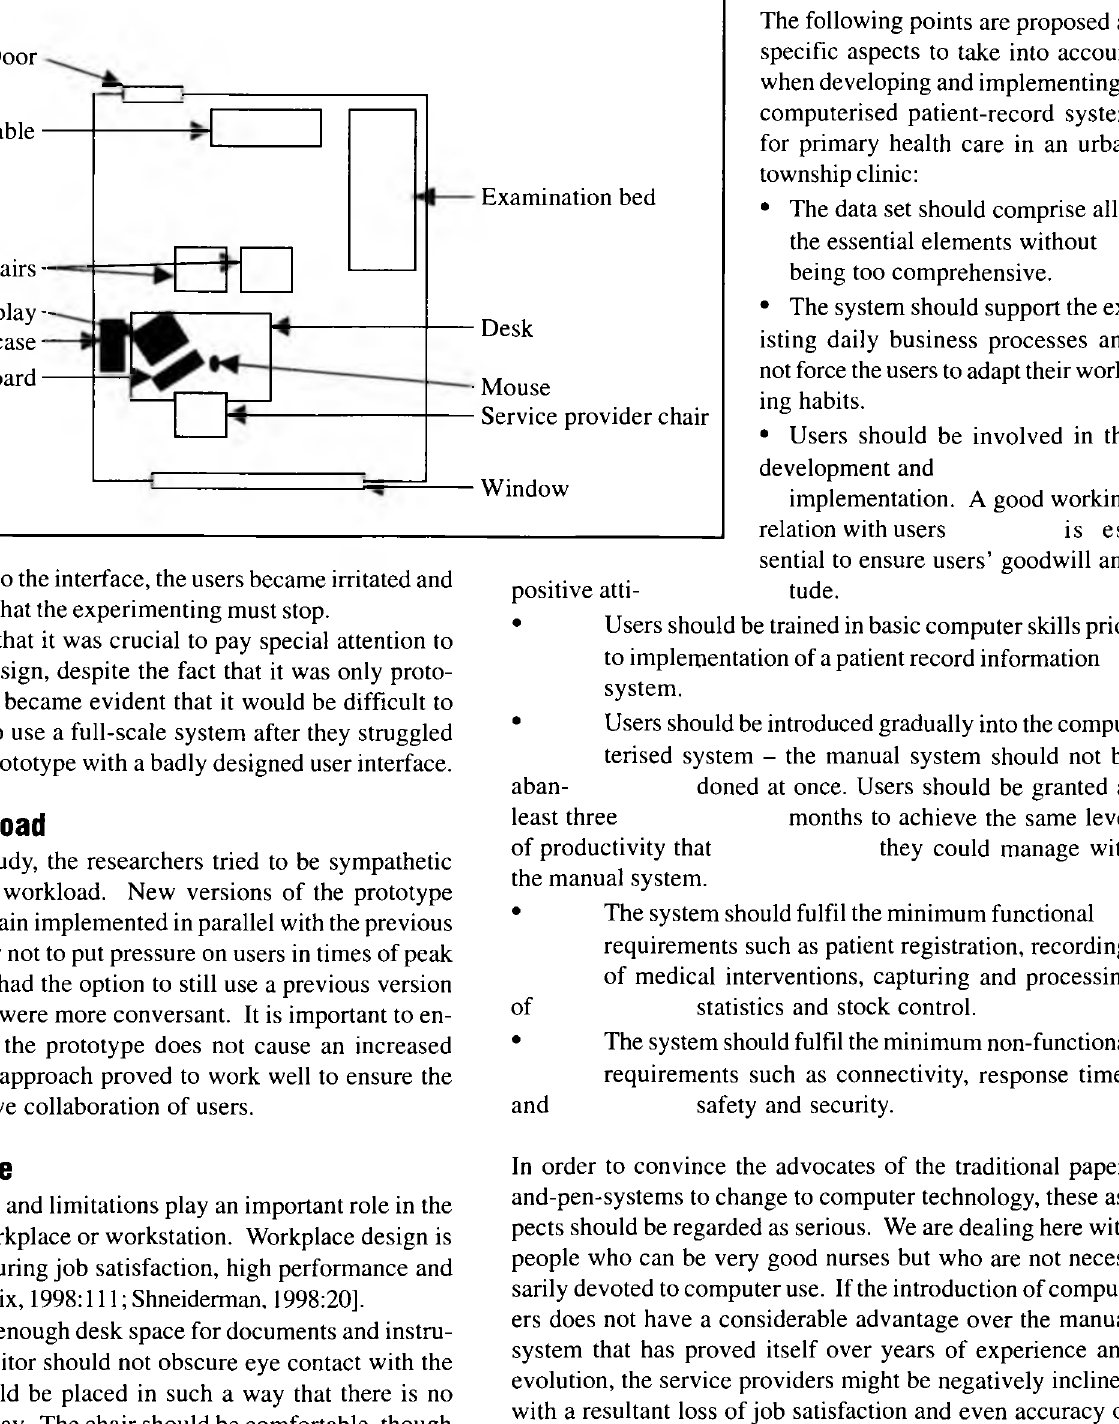
Figure 1 1 : Typical layout of a consultation